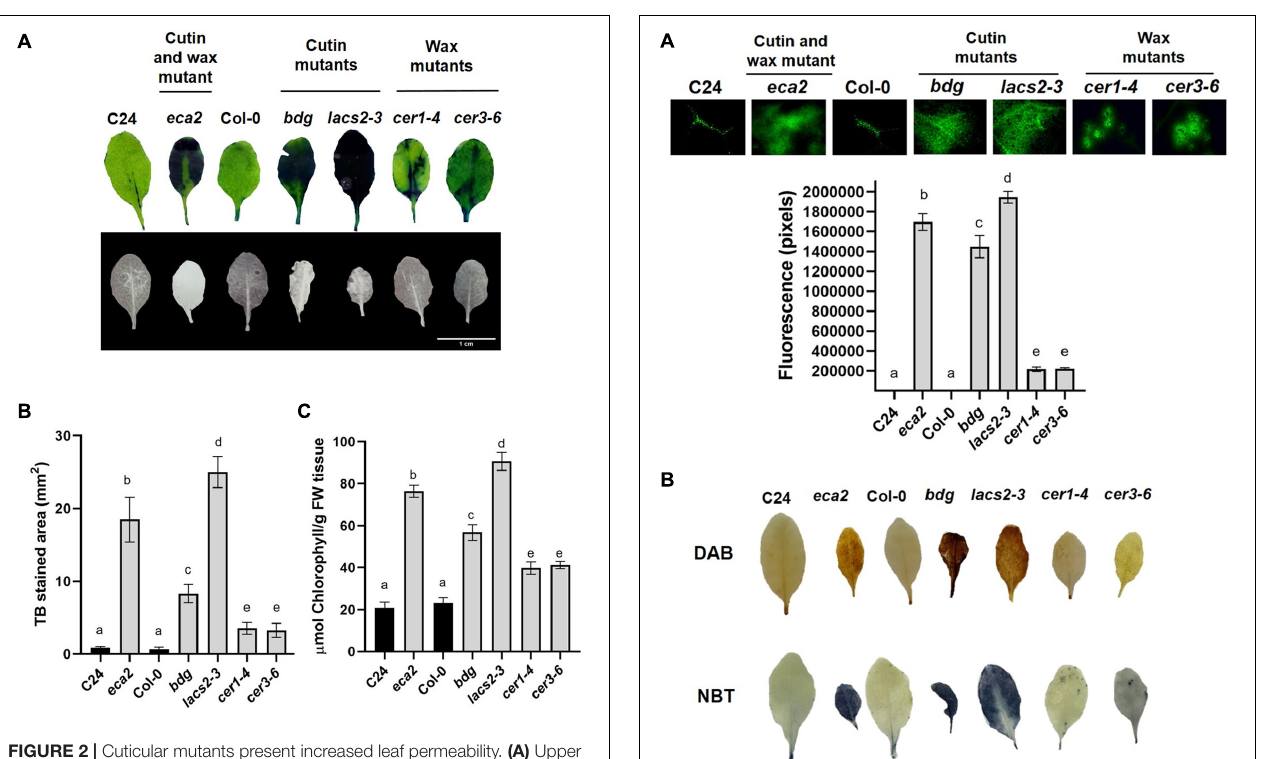
FIGURE 2 | Cuticular mutants present increased leaf permeability. (A) Upper panel: leaves of 4-week-old WT plants and the cuticular mutants were stained with toluidine blue. Lower panel: leaves were stained with calcofluor white and viewed under UV light. (B) Toluidine blue-stained areas were quantified using the Fiji software. (C) Chlorophyll leaching 60 min after immersion of the leaves on 80% EtOH was spectrophotometrically measured as previously described (L’Haridon et al., 2011). Different lowercase letter columns indicate significant differences according to one-way analysis of variance (ANOVA) ( p -value < 0.001) followed by Tukey’s test. Representative pictures are shown.